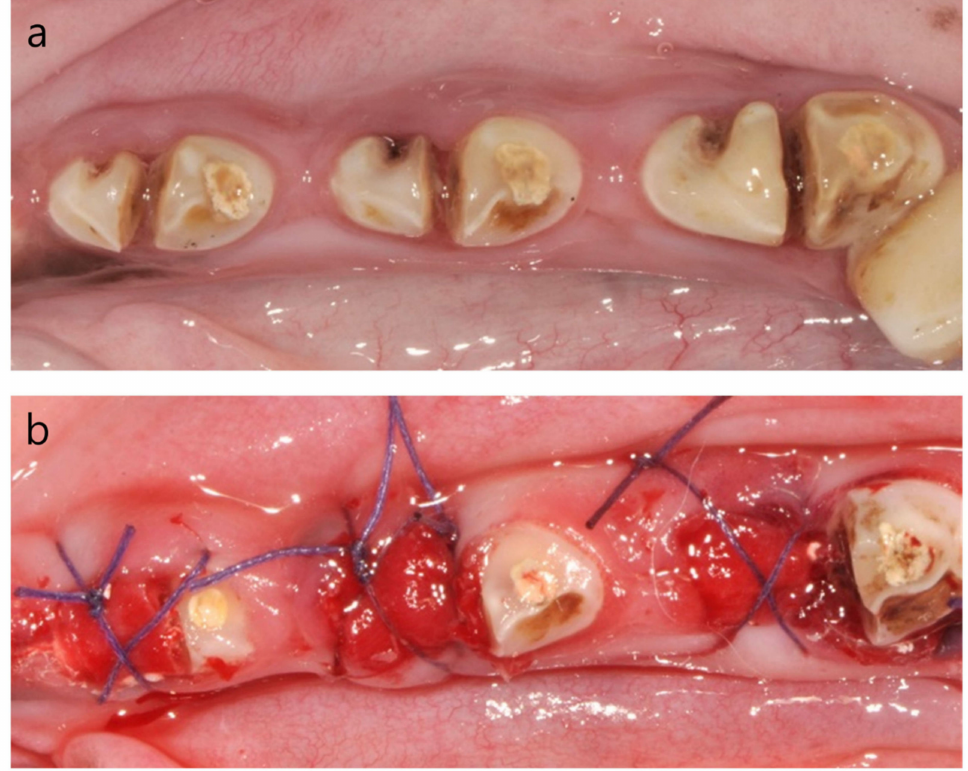
Figure 3. Clinical photographs ( a ) before extraction and ( b ) after ridge